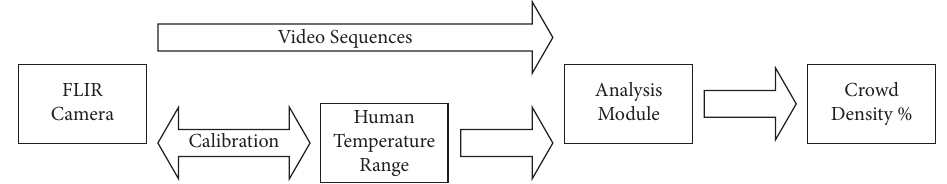
Figure 2: Te framework of the proposed algorithm is given in [20].